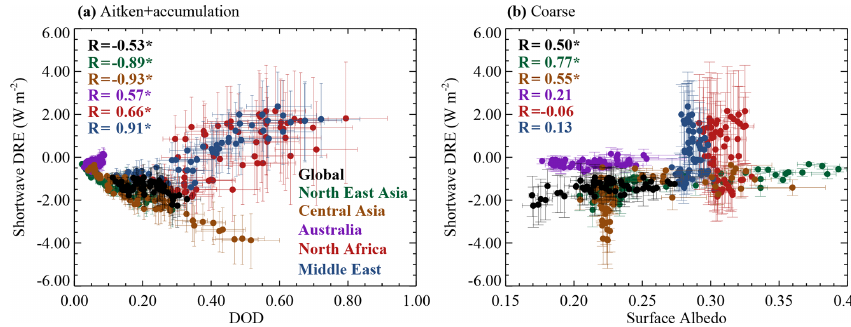
Figure 14. As in Fig. 13 but for shortwave DRE versus DOD and surface